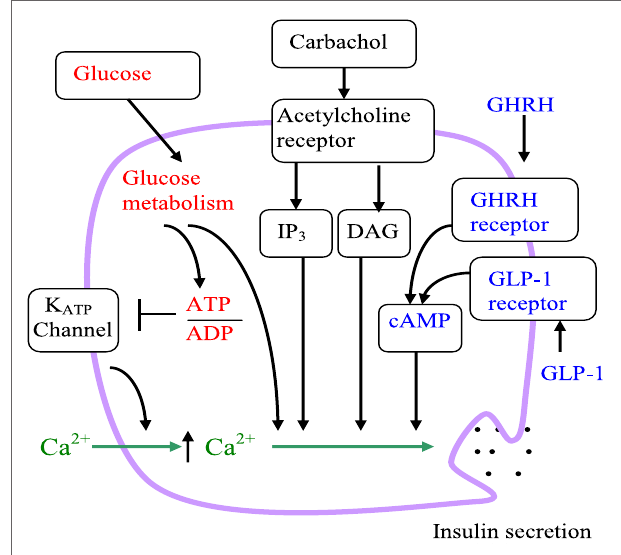
FiGURe 2 | Schematic of the beta-cell signaling pathways and hypothetical role of GHRHR . Arrows indicate activation or an increase in concentration. The line ending with a bar indicates inhibition or closure. Glucose metabolism increases the ATP/ADP ratio, leading to the closure of K ATP channels, reduction of K + efflux, membrane depolarization, increase of intracellular Ca 2 + , and insulin secretion. Glucose also leads to insulin secretion through amplifying pathways that are independent of K ATP channels. Carbachol stimulation enhanced insulin secretion via the acetylcholine (muscarinic) receptor and phospholipase C pathways. IP 3 is inositol 1,4,5-trisphosphate, DAG is diacylglycerol. As depicted, GLP-1 and GHRH both enhance insulin secretion via the cAMP